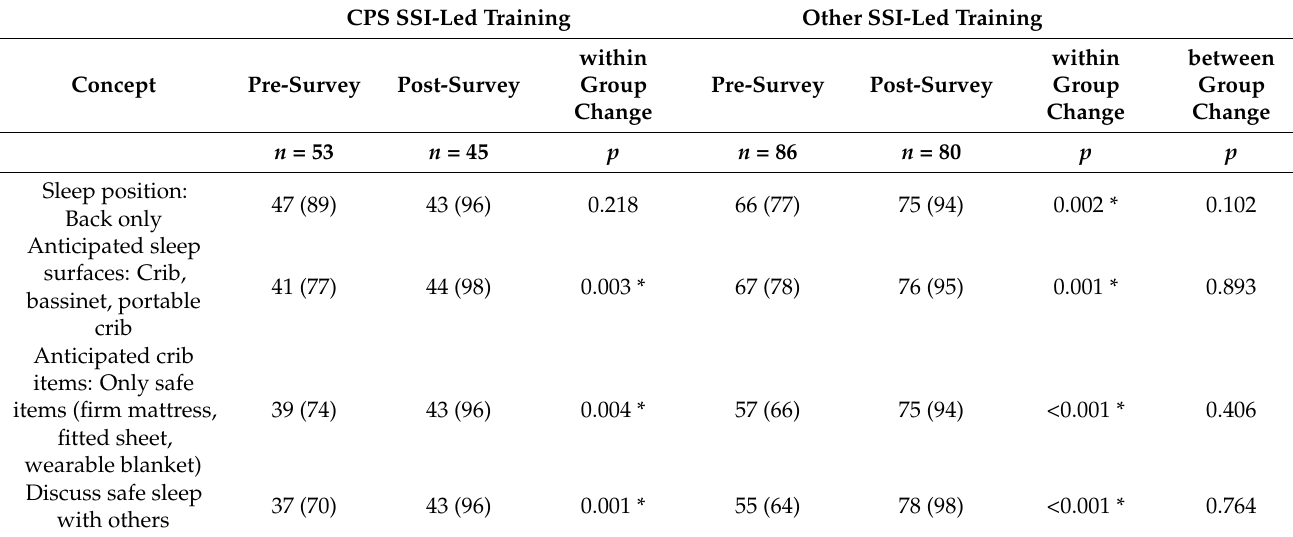
Table 2. Parents and caregivers reporting only safe/correct responses for intended safe sleep